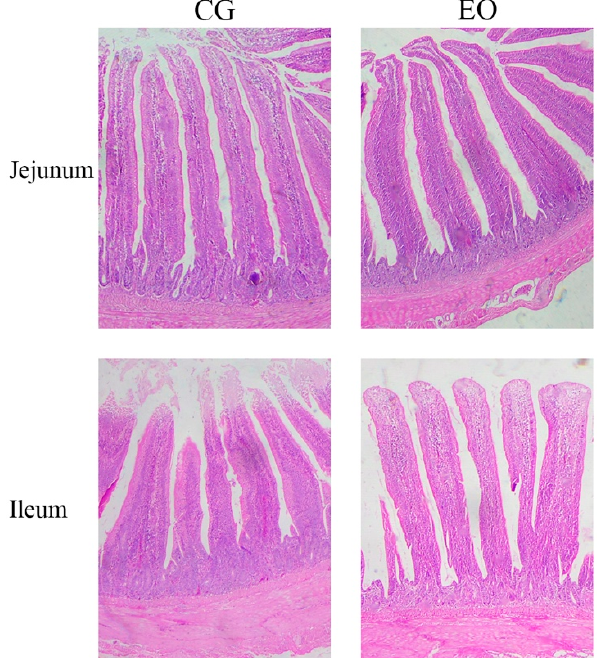
Figure 1. Jejunal and ileal mucosa photomicrograph with typical crypts and villi. The scale bar is 200 μ m. Eosin and haematoxylin stain. Magnification was 100×. Abbreviations: CG, control group; EO, essential